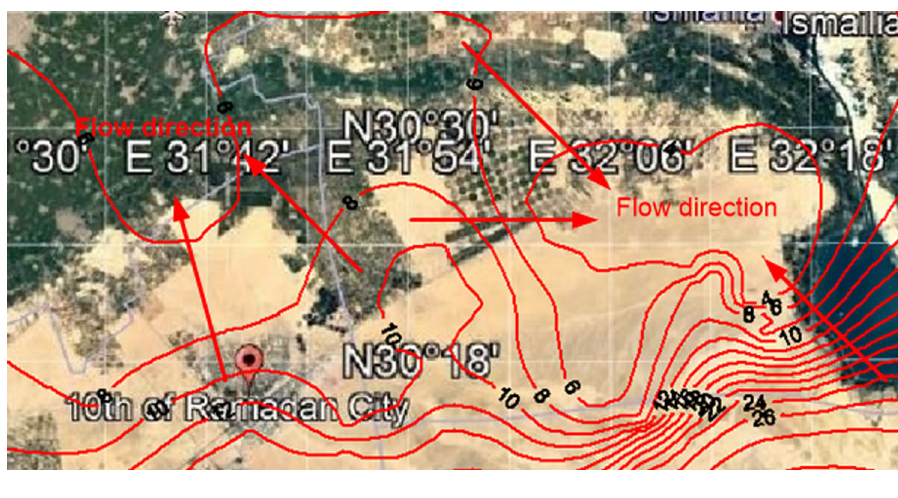
Fig. 3 Water table contour map of the selected groundwater wells during Dec 2005 (After Gad et al. 2015)